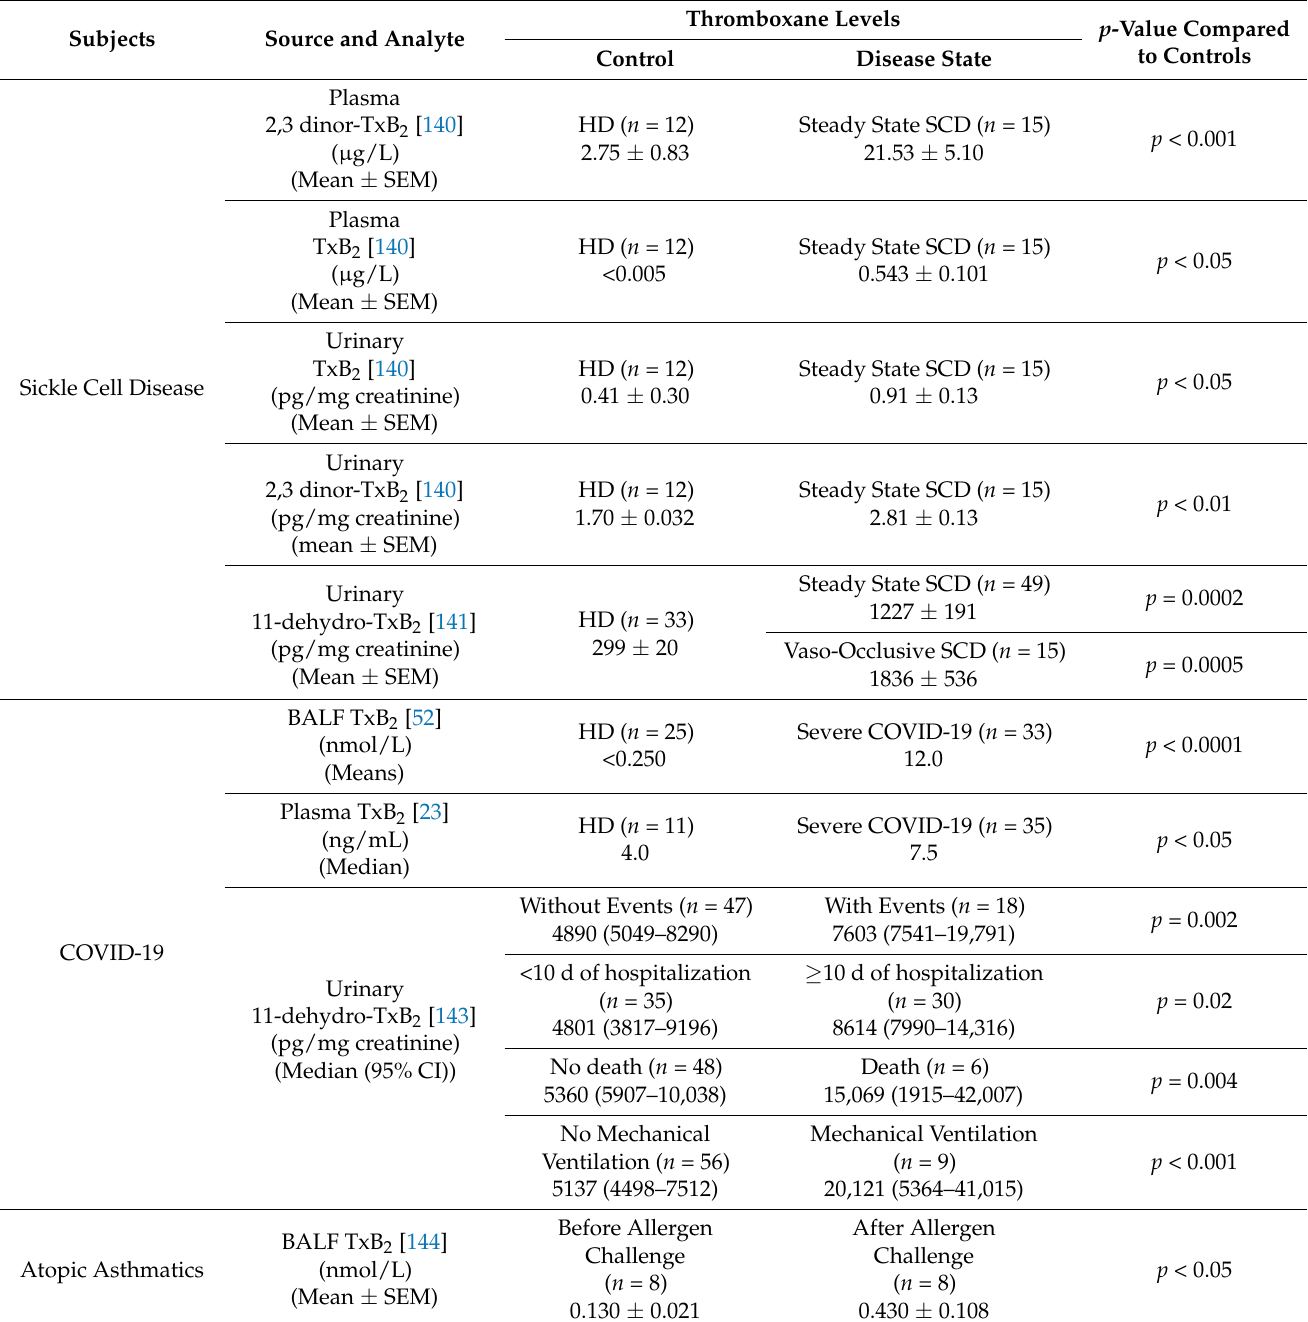
Table 2. Comparative analysis of thromboxane levels in SCD, COVID-19, and